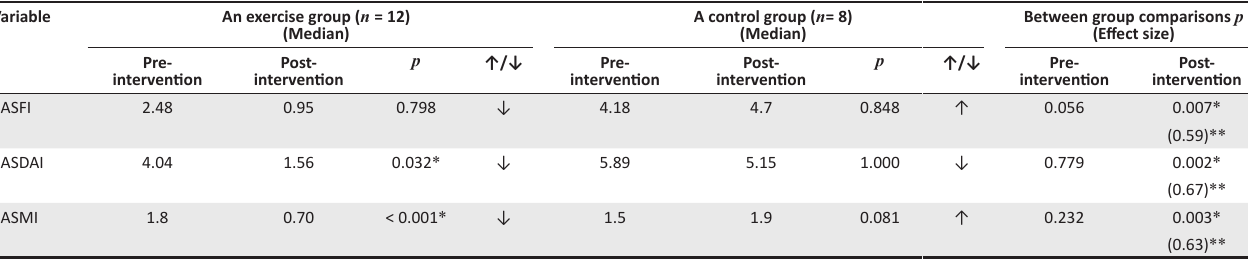
TABLE 5: Functional assessments pre-and post-intervention, within and between groups ( n = 20).